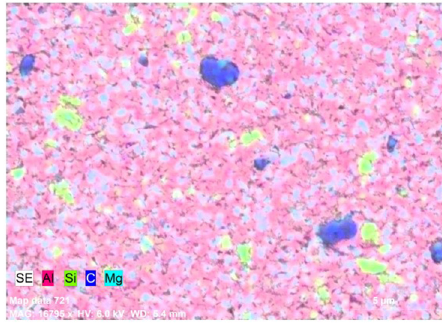
Figure 7: Element distribution of Al and CFRP joint.